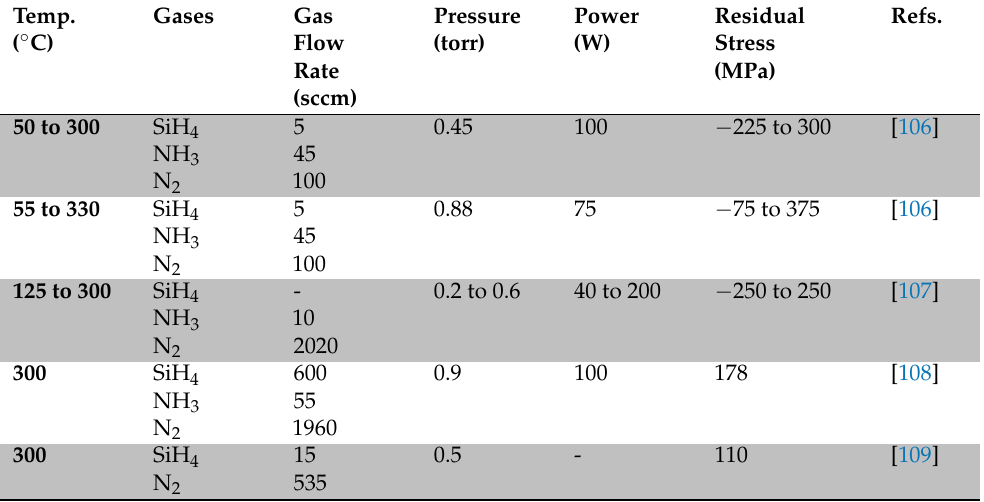
Table 8. Reported residual stresses for PECVD silicon nitride thin-film layers for various process recipes. Temp.